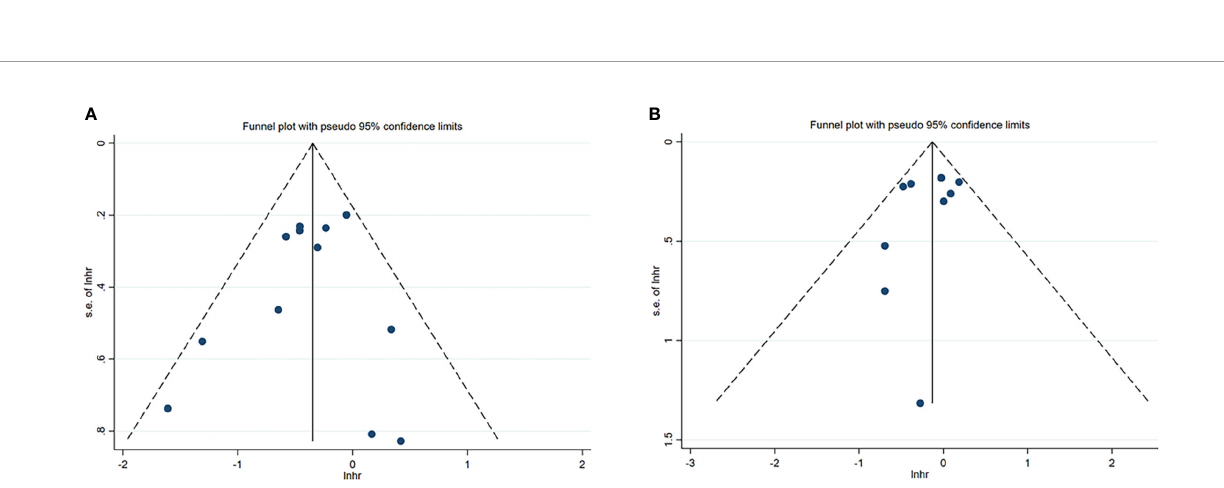
Figure 7A ; Egger ’ s test: P=0.564, Figure 7B ). Similarly, no signi fi cant publication bias was found for DFS/RFS/TTR/PFS analysis (Begg ’ s test: P=0.602, Figure 7C ; Egger ’ s test: P=0.401, Figure 7D ).